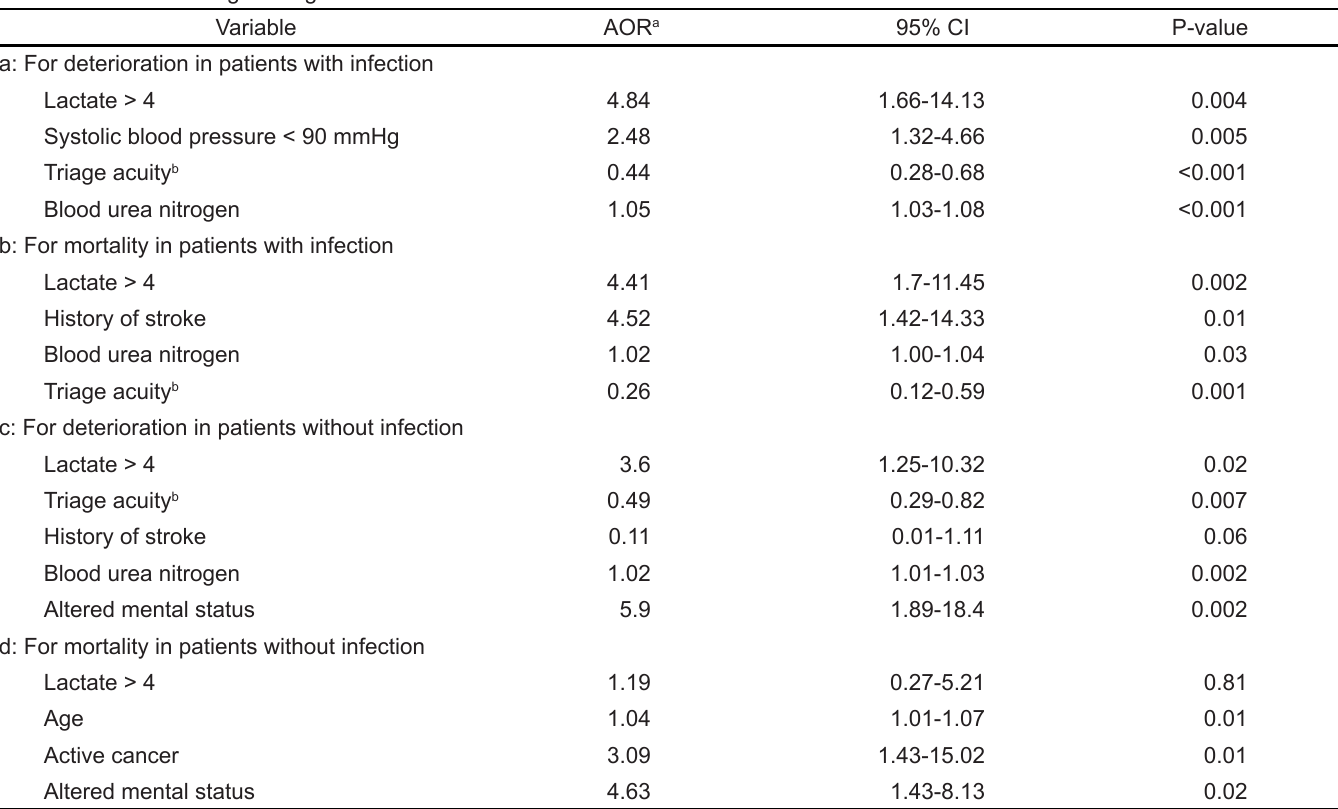
Table 4. Multivariable logistic regression